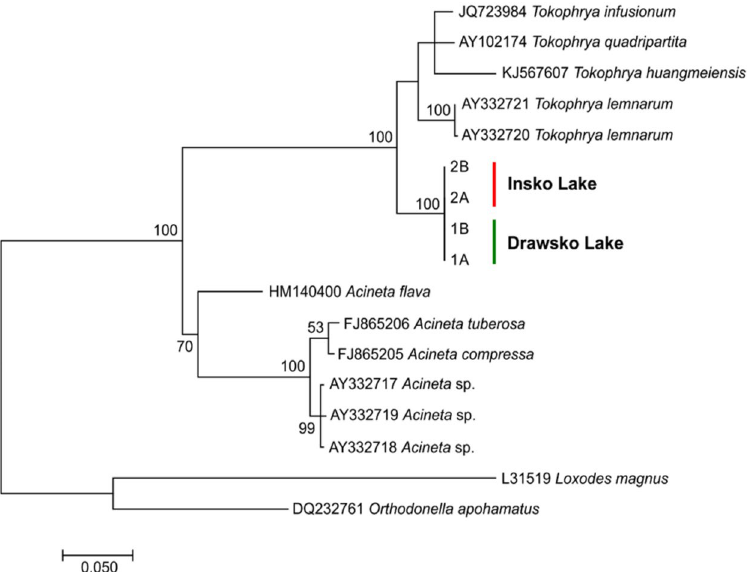
Figure 3. Maximum Likelihood tree based on partial 18 S rRNA sequences showing the phylogenetic relationships among the representatives of Tokophryidae and Acinetidae. Numbers at the nodes represent the bootstrap values. Only values over 50 are